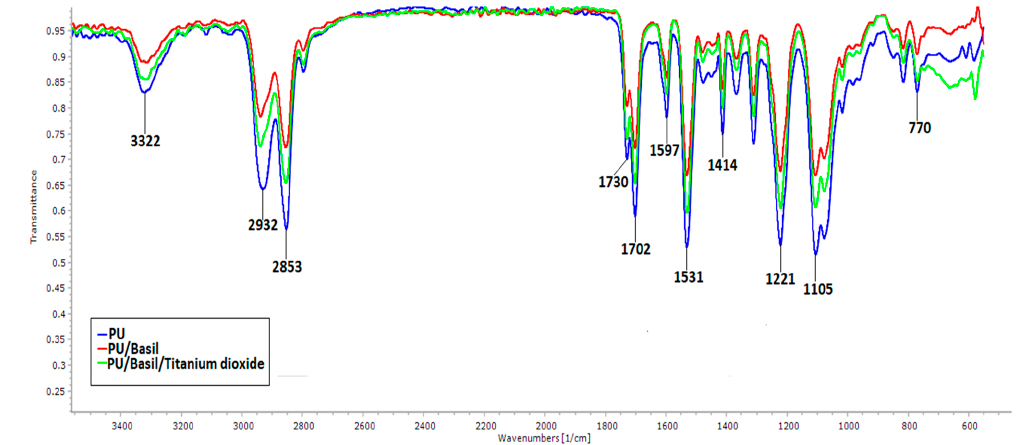
Figure 5. Fourier transform infrared (FTIR) spectroscopy analysis of PU, PU/BASIL and PU/BASIL/TiO 2 .